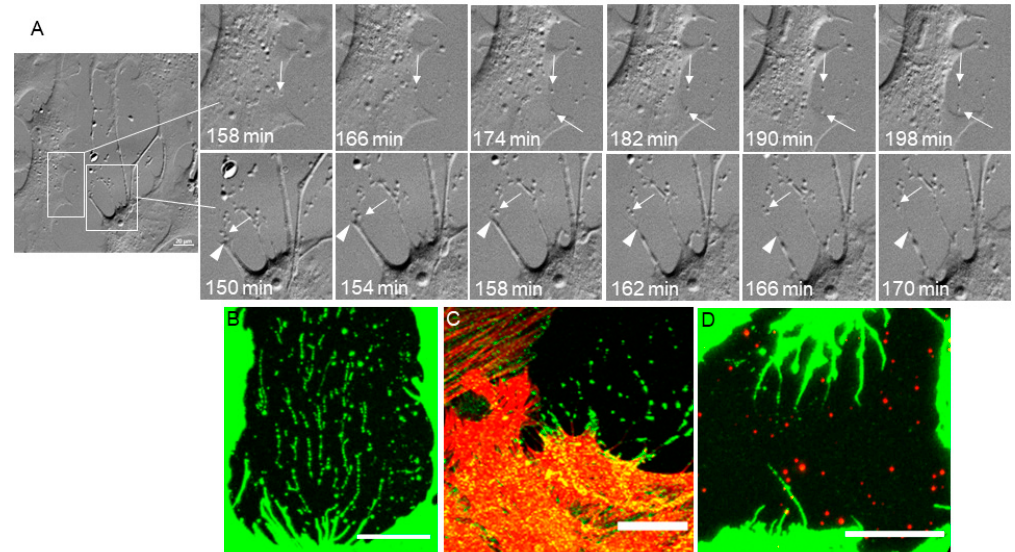
Figure 4. ( A ) Still images taken from the movie shown in Supplemental Figure S2A. Phase gradient contrast images shows two mechanisms of extracellular vesicle (EV) deposition. The top panels show secretion of actin-rich intracellular vesicles from the cell over the course of 40 min (158–198 min). Bottom phase gradient contrast images show the cleavage of filopodial tips as they retract back to the cell over the course of 20 min (150–170 min). Scale = 20 µm. Fixed NTM cells immunostained with ( B ) CD44, ( C ) integrin α V β 5 (green) and SiR-actin (red), and ( D ) ADAMTS4 (red) and CD44 (green). Scale = 20 µm.